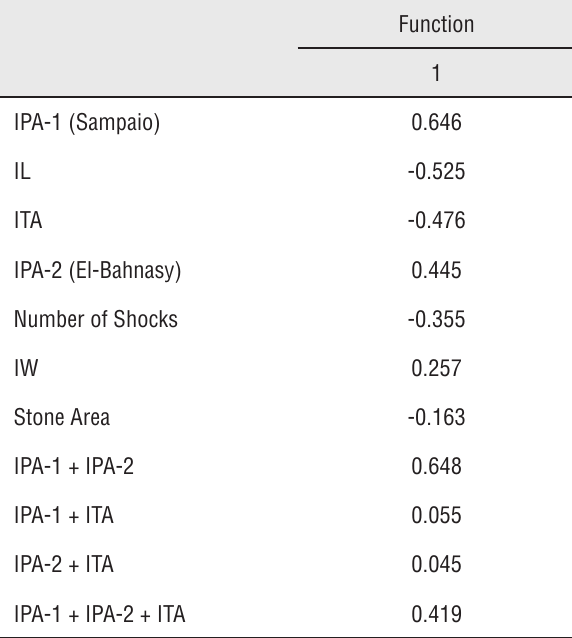
Table 3 - Structure Matrix. Negative values indicates inverse relationship of variables with